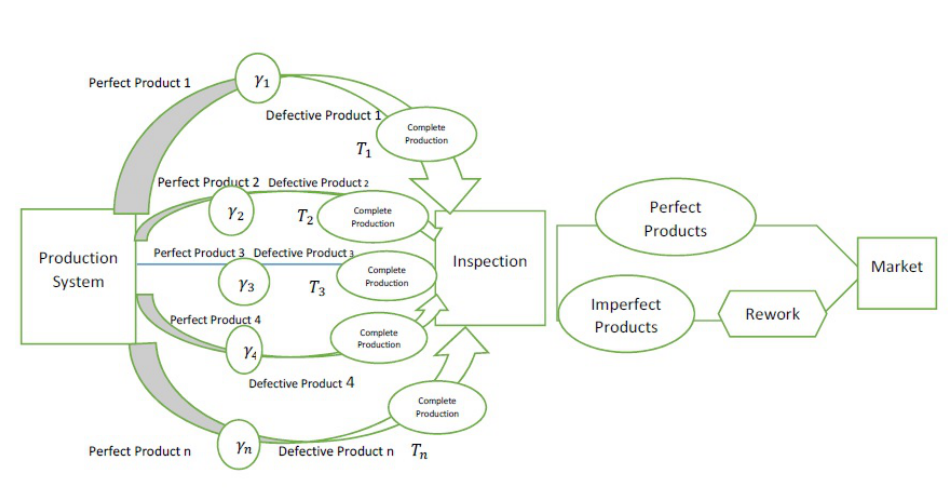
Figure 1. Complex production management with system